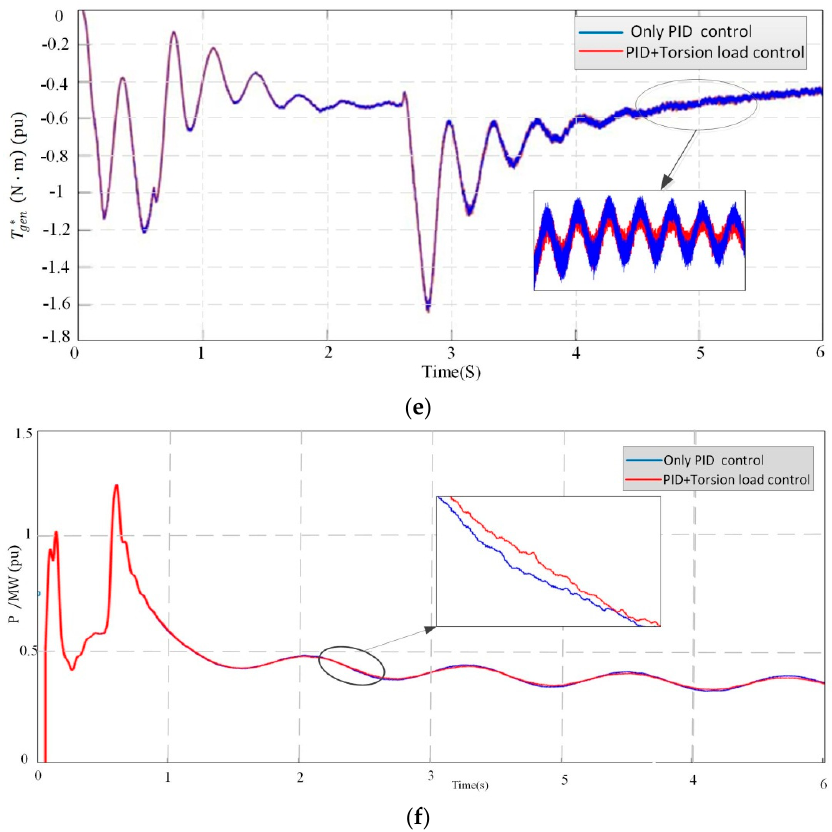
Figure 10. Simulation Results under Turbulent wind. ( a ) Turbulent wind; ( b ) Output mechanical torque on the shaft ( T shaft ); ( c ) Torsion vibration angle ( θ s ); ( d ) The electromagnetic torque reference value ( T e * ); ( e) The given value of the electromagnetic torque ( T gen * ); ( f ) Active power ( p ).